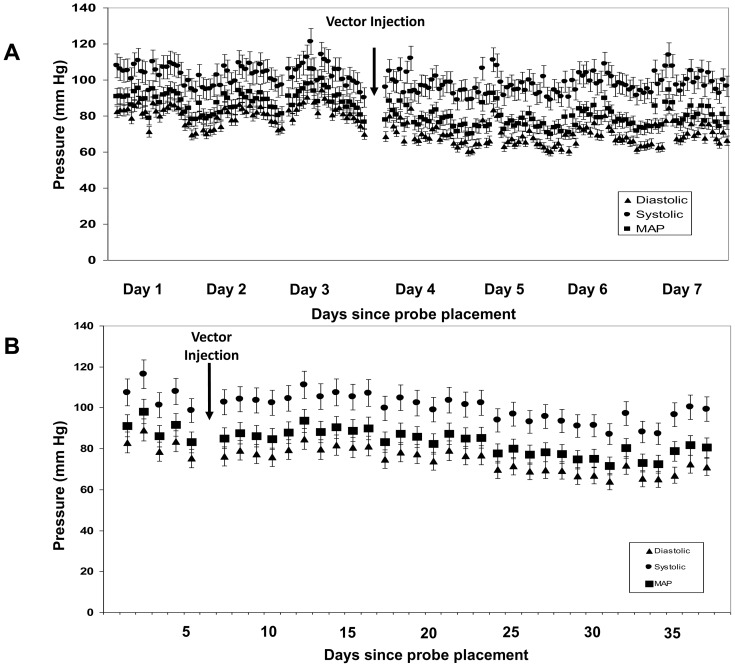
Representative graph showing the (A) diurnal short-term and (B) hourly long-term variation in maternal blood pressure before and after the administration of the vector.There were no significant changes in maternal haemodynamics after Ad.VEGF-DΔNΔC administration when compared to baseline. Error bars represent SEM.